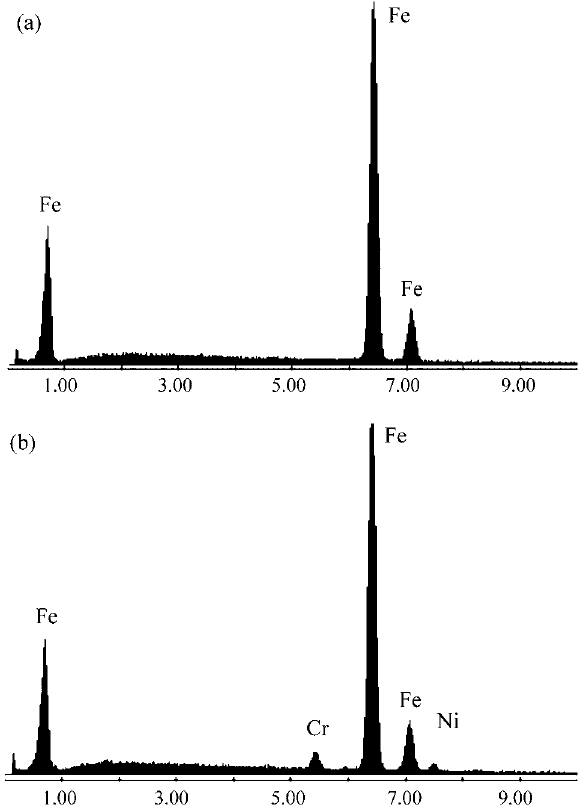
Figure 3. Chemical spectra of samples processed with a radial spacing between the cathodes of 3.2 mm: a) spectrum from the base of the sample; and b) spectrum from the lateral surface of the